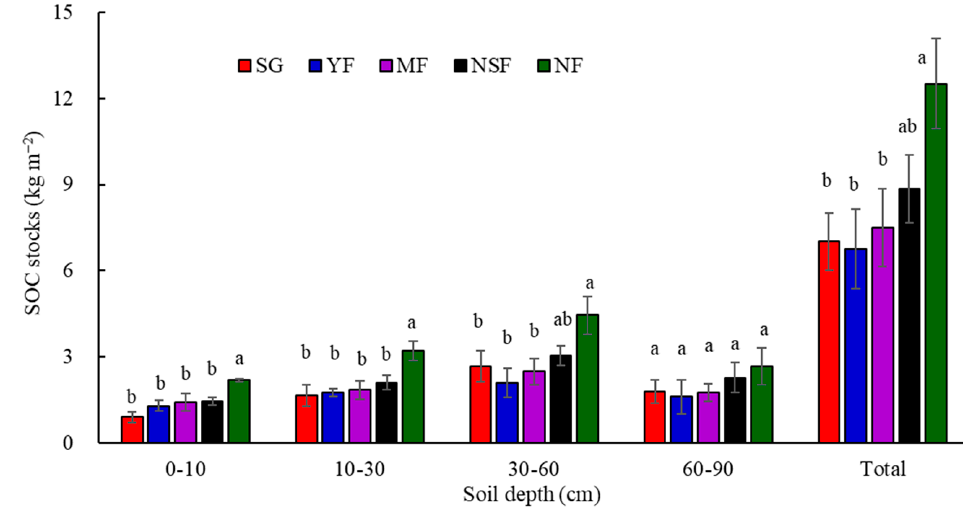
Figure 5. Soil organic carbon (SOC) stocks at different soil depths for five vegetation types. Values are the means ± standard error. Different letters indicate significant differences between vegetation types at the same soil depths at the 0.05 level.